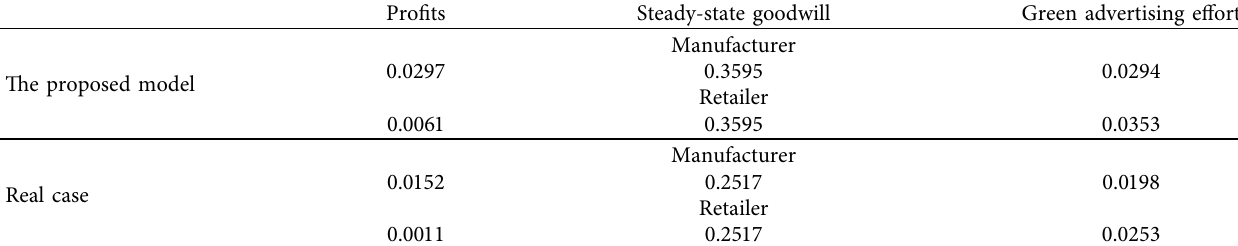
Table 9: Optimal decisions for case